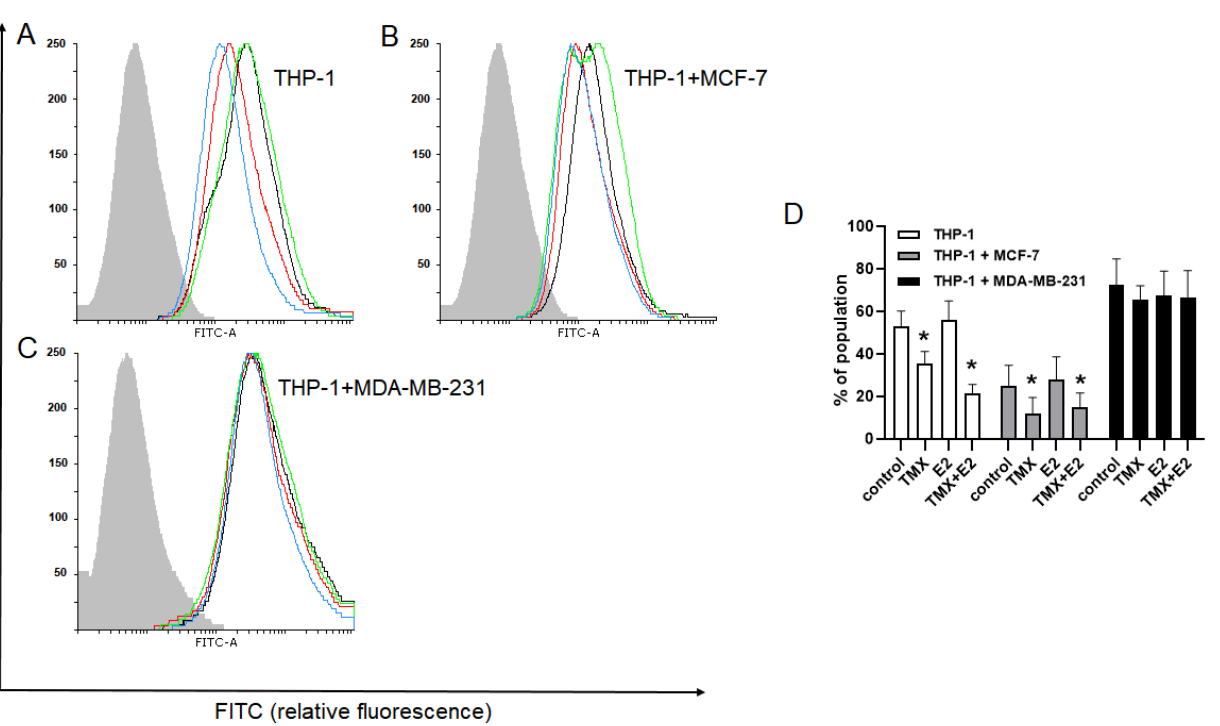
Figure 1. Flow cytometric analysis of monocytic THP- 1 cells for the expression of TNFα, IL - 1β, IL - 6, IL-8, IL-10 and IL-12p70. Cells were grown in a monoculture or the presence of MCF-7 and MDA- MB-231 cells in a co- culture transwell system, and exposed to TMX (10 μM) and/or E2 (100 nM) for 24 h. Each column presents the mean concentration from 3 independent experiments. * p < 0.05 vs. the corresponding control group; # concentration < 0.01 pg/mL.